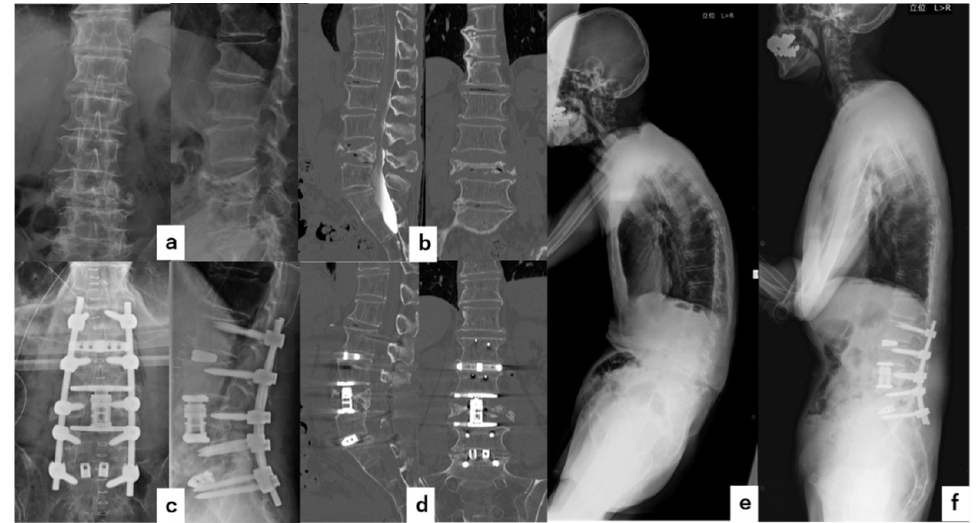
Figure 4. Illustrative Case 2. A seventy-five-year-old male underwent a combined anteroposterior two above–two below fixation with a wide footplate expandable cage for pseudarthrosis after OVF at L4. ( a ) Preoperative anteroposterior and lateral radiographs showing that the local kyphosis angle was 29°. ( b ) Preoperative coronal and sagittal CT. ( c ) Immediate postoperative anteroposterior and lateral radiographs. ( d ) Postoperative sagittal CT. ( e ) Preoperative whole-spine lateral radiograph. ( f ) Postoperative whole-spine lateral radiograph.